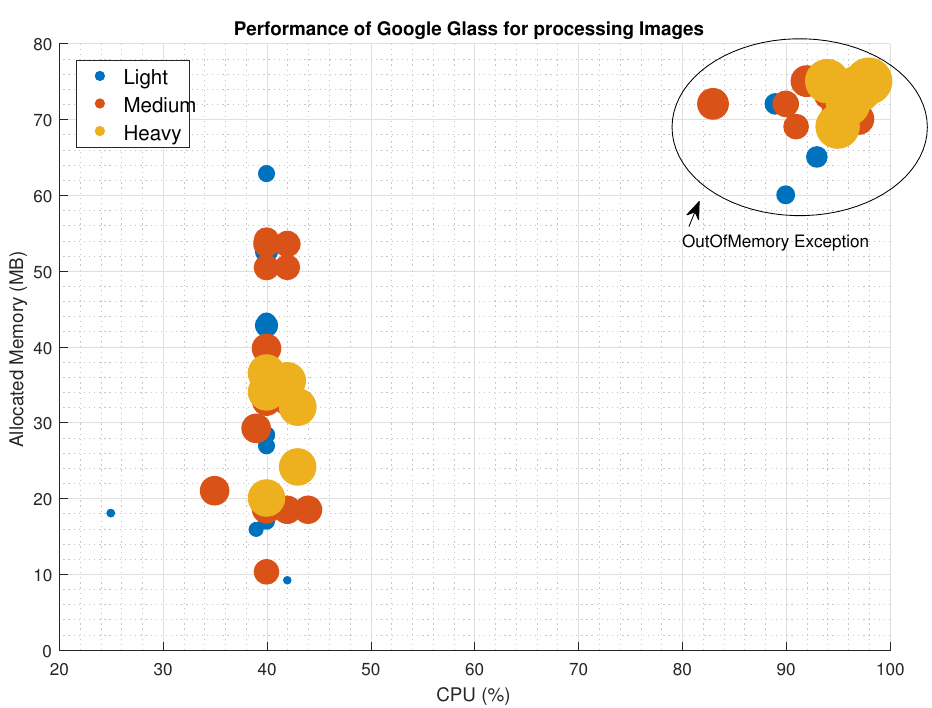
Figure 5. Performance (CPU and Memory use) of Google Glass for processing images of different sizes. The area of the circle is in proportion to the image